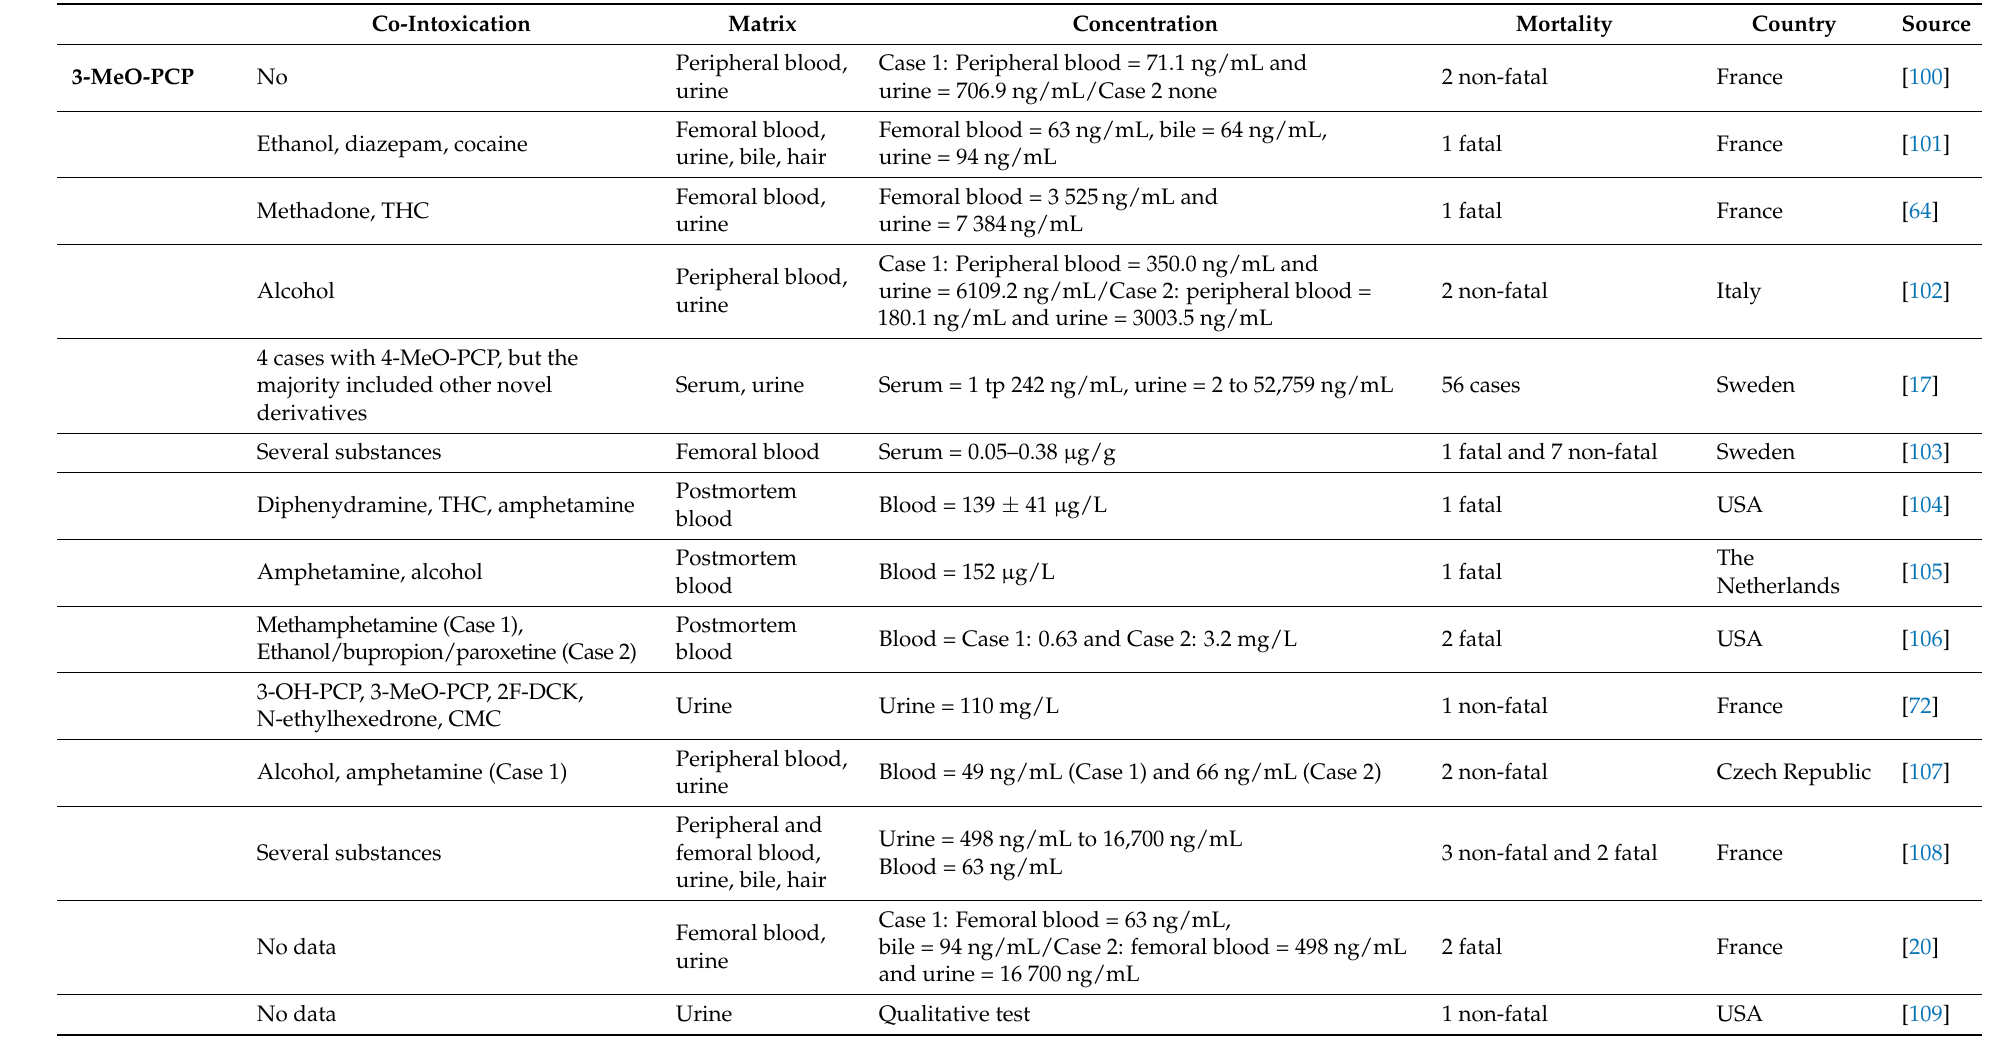
Table 2. Literature reports of intoxications involving ACH derivatives other than